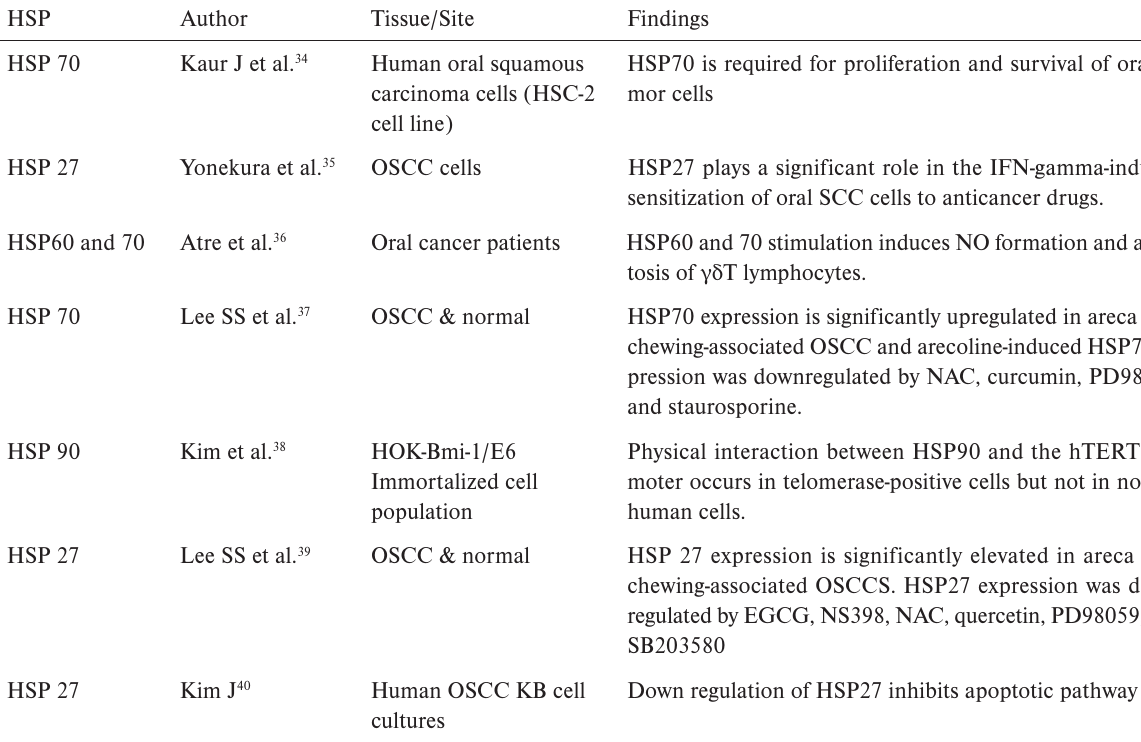
Table 3. Implications in therapuetics of oral